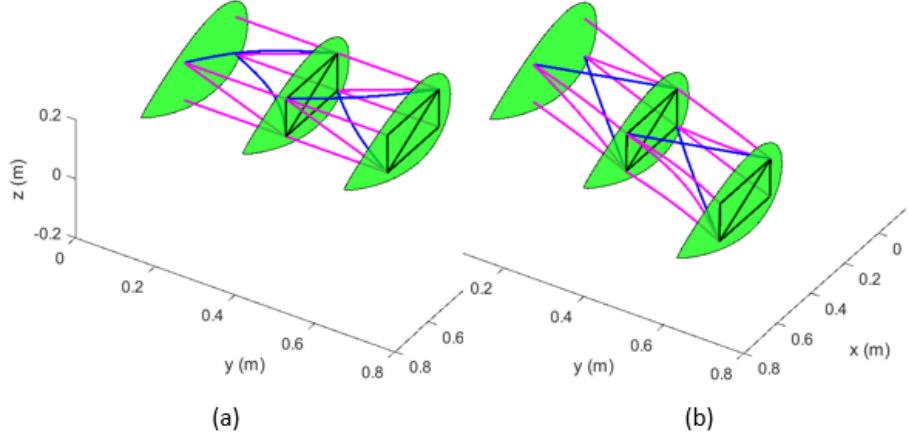
Figure 15. Seventh mode shape for the system in the ( a ) un–morphed configuration, ( b ) morphed configuration (simulation